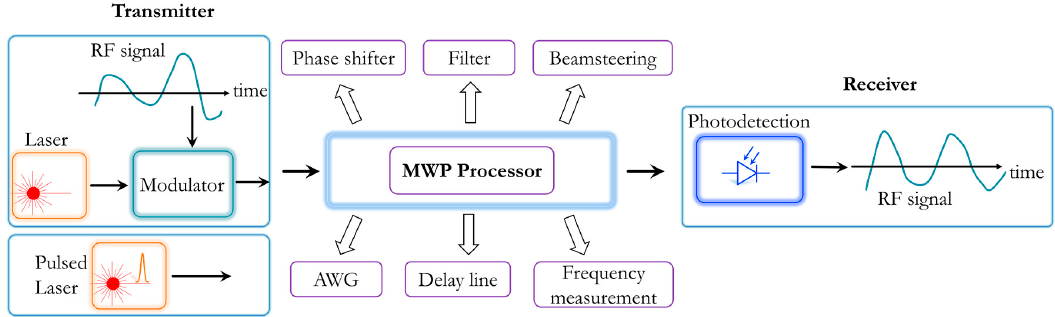
Figure 1. Architecture of a generic microwave photonic system. AWG: arbitrary waveform generation; MWP: microwave photonics; RF: radio-frequency.